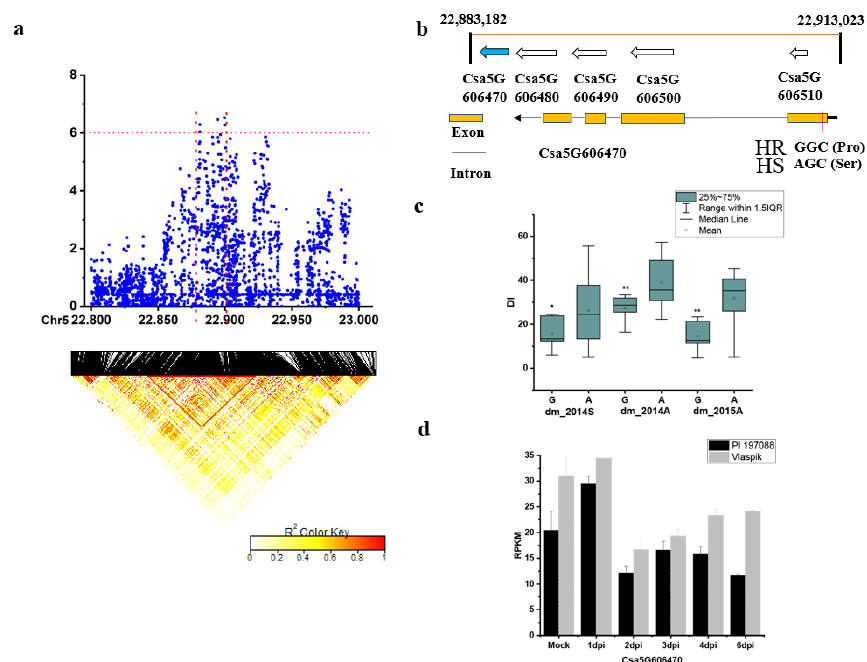
Figure 8. Identification of the causal gene for the locus dmG5.2 . ( a ) Local Manhattan plot (top) and LD heatmap (bottom) surrounding the peak of dmG5.2 ; ( b ) five genes predicted in the LD block region and SNP variation of the candidate gene Csa5G606470 between the highly susceptible (HS) and highly resistant (HR) lines (see Supplementary File 5); ( c ) disease index (DI) comparison between haplotypes of the HS and HR lines (see Supplementary File 3); ( d ) RPKM of the candidate gene Csa5G606470 based on the transcriptome of PRJNA285071 (data obtained from http://cucurbitgenomics.org/rnaseq/cu/19) [24]. * and ** indicate significance at p < 0.05 and p < 0.01, respectively.